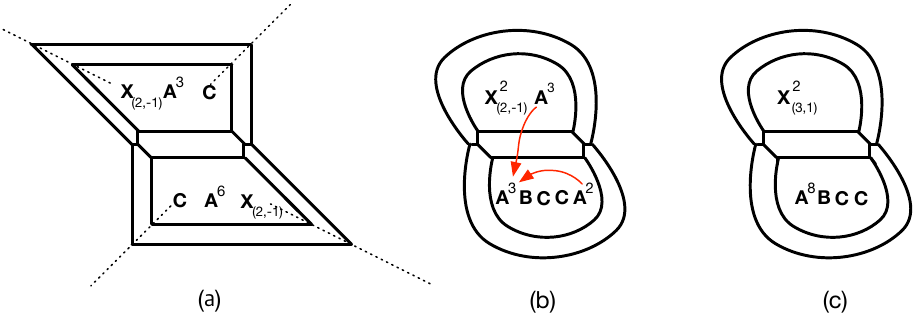
Figure 16 . (a) 7-brane con(cid:12)gurations for 5-brane web in (cid:12)gure 15 where all the 7-branes are put in the 5-brane loops. (b) Rearrangement of 7-branes. (c) 7-brane con(cid:12)gurations showing the non-abelian part of the global symmetry being an E 8 (cid:2) SU(2) symmetry.